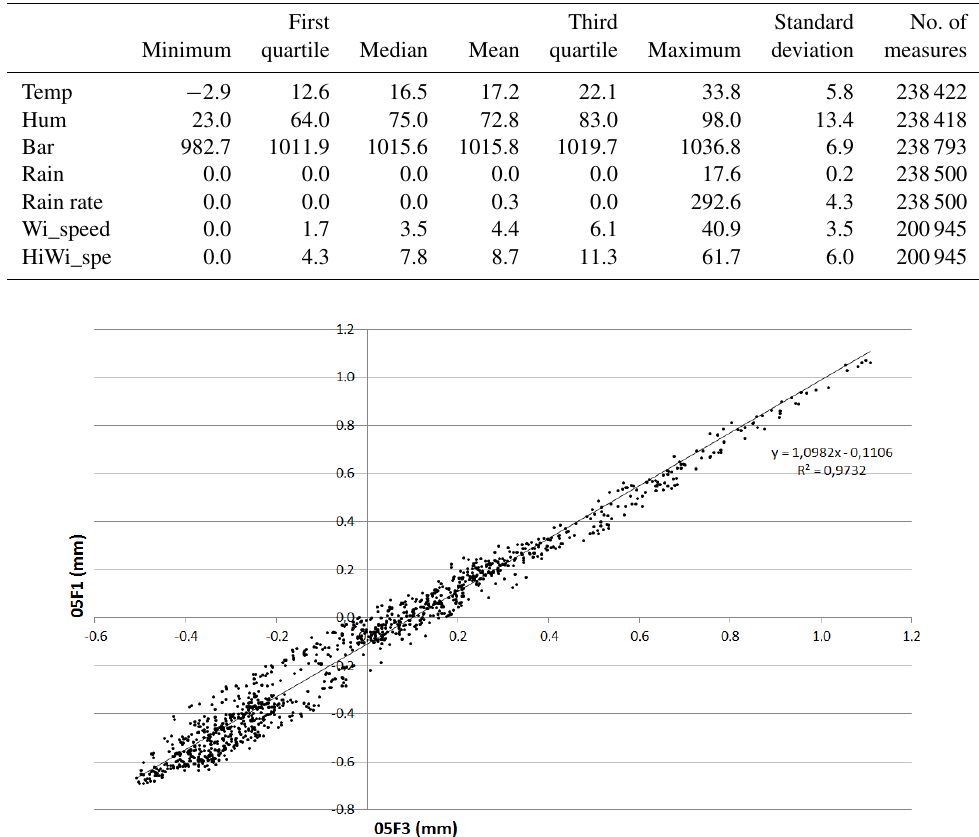
Figure 7. Correlation plot between 05F1 and 05F3